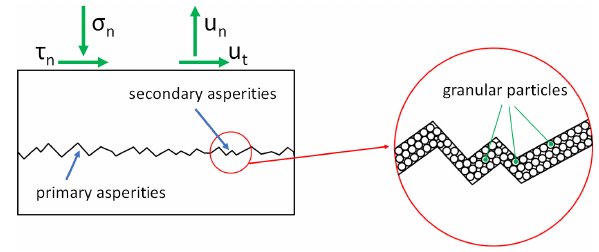
Figure 3: Primary and secondary